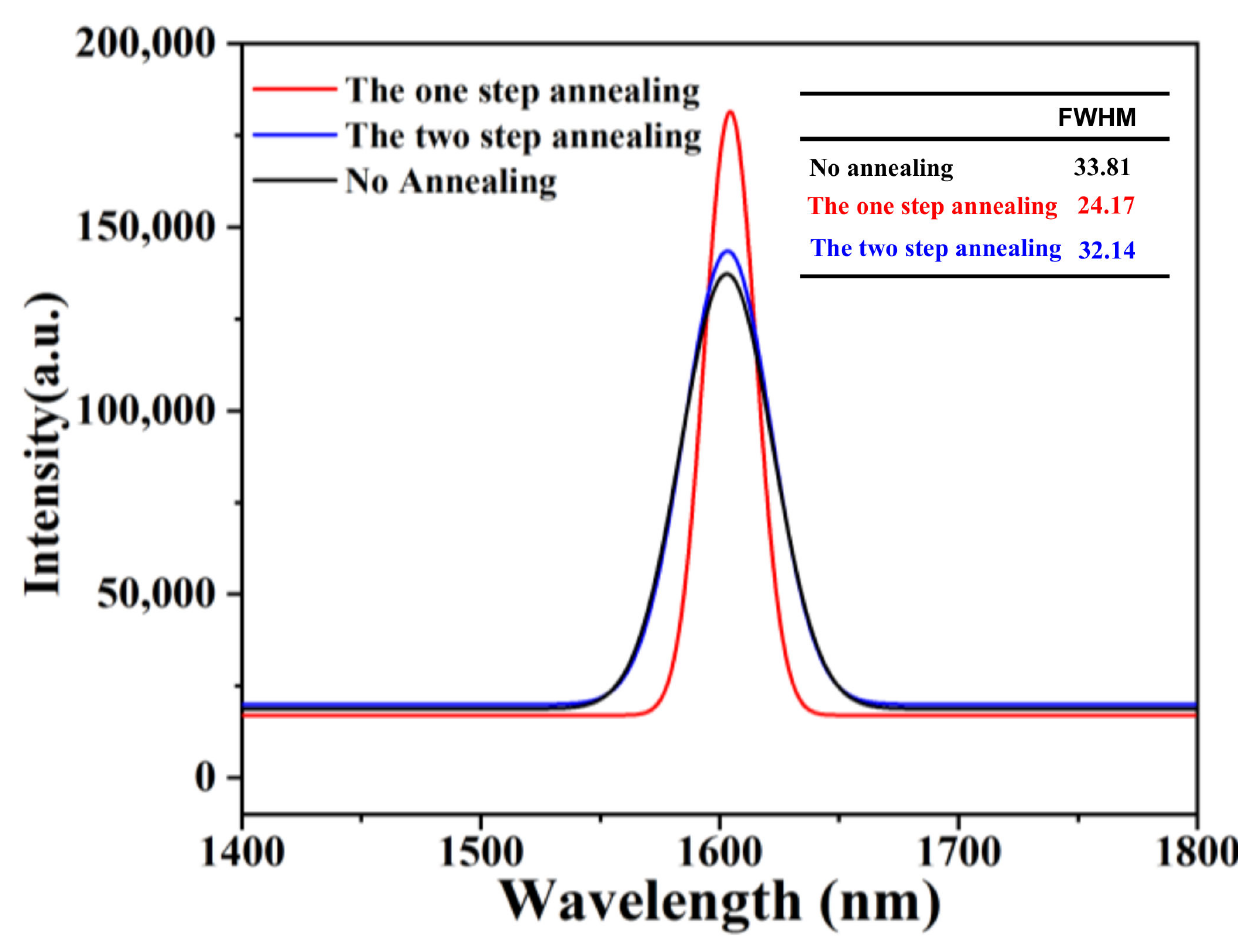
Figure 14. Room temperature of photoluminescence spectrum of two-step grown 1.4 µ m Ge layers using different annealing processes.